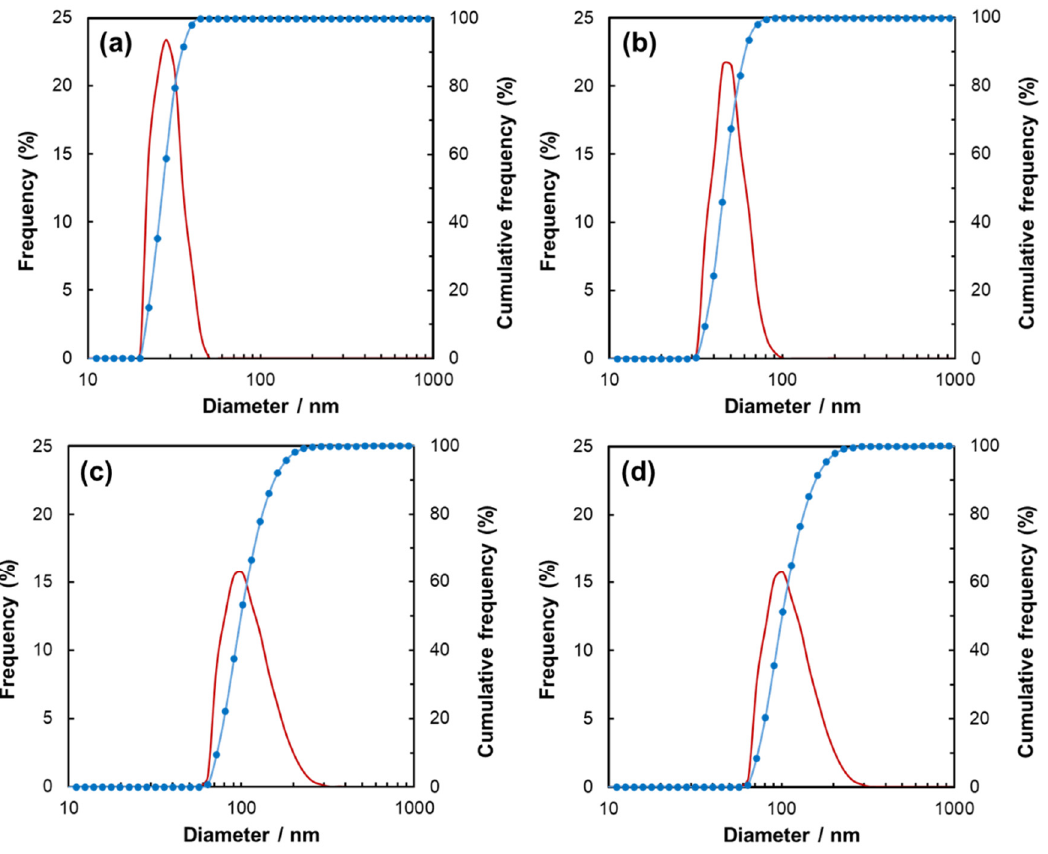
Figure 3. Particle diameter distribution of ( a ) PLHA-V0, ( b ) PLHA-V50, ( c ) PLHA-V100, and ( d ) PLHA-V200. Red solid lines represent the appearance frequency, and blue solid lines represent the cumulative frequency.